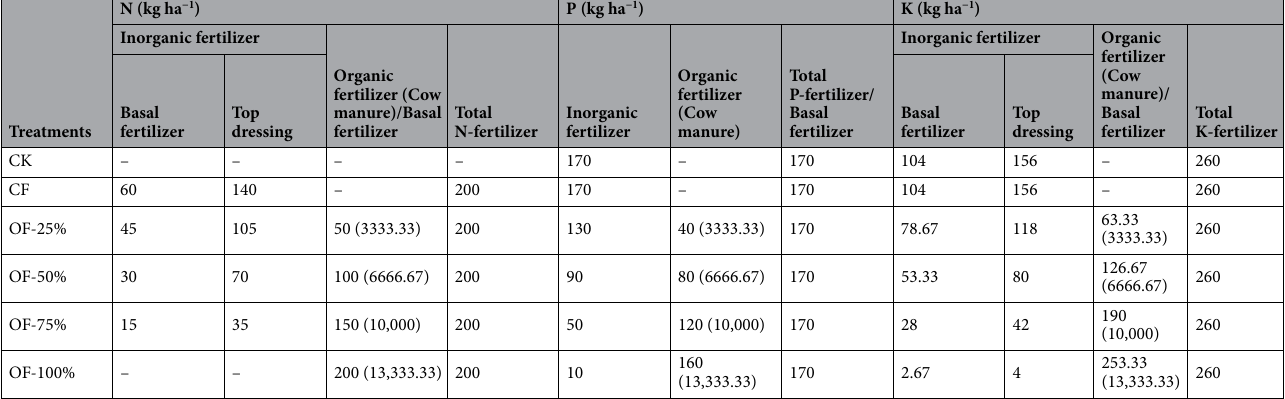
Table 2. The fertilizer ratio and amount for the different treatments in 2014–2018. The plot size was 10 m × 6.4 m = 64 m 2